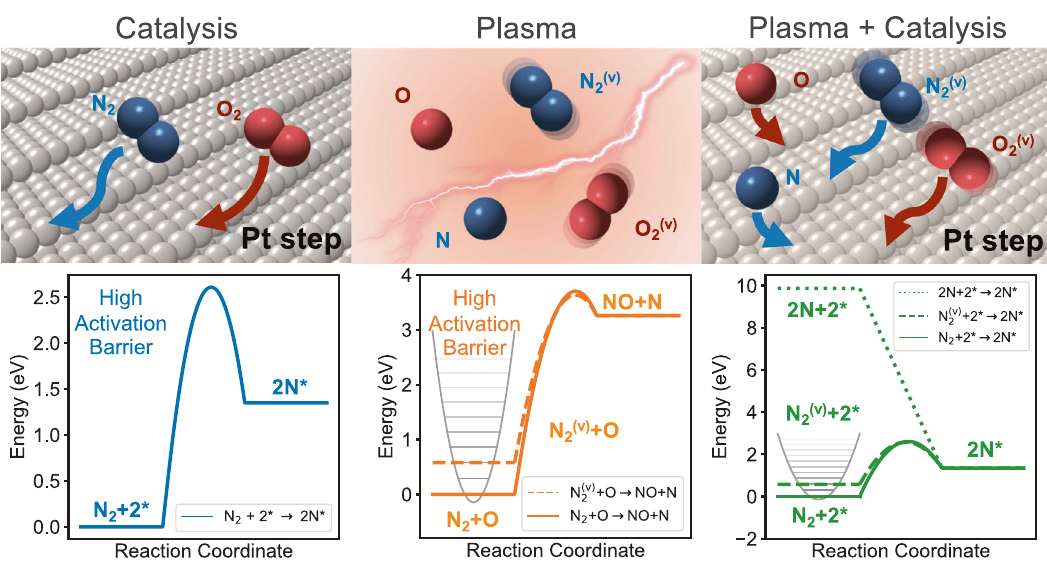
Fig. 2 N 2 activation pathways. Schematic representations of active species (top) and potential energy surfaces of different N 2 activation processes (bottom) in thermal catalysis, non-thermal plasma and non-thermal plasma coupled with